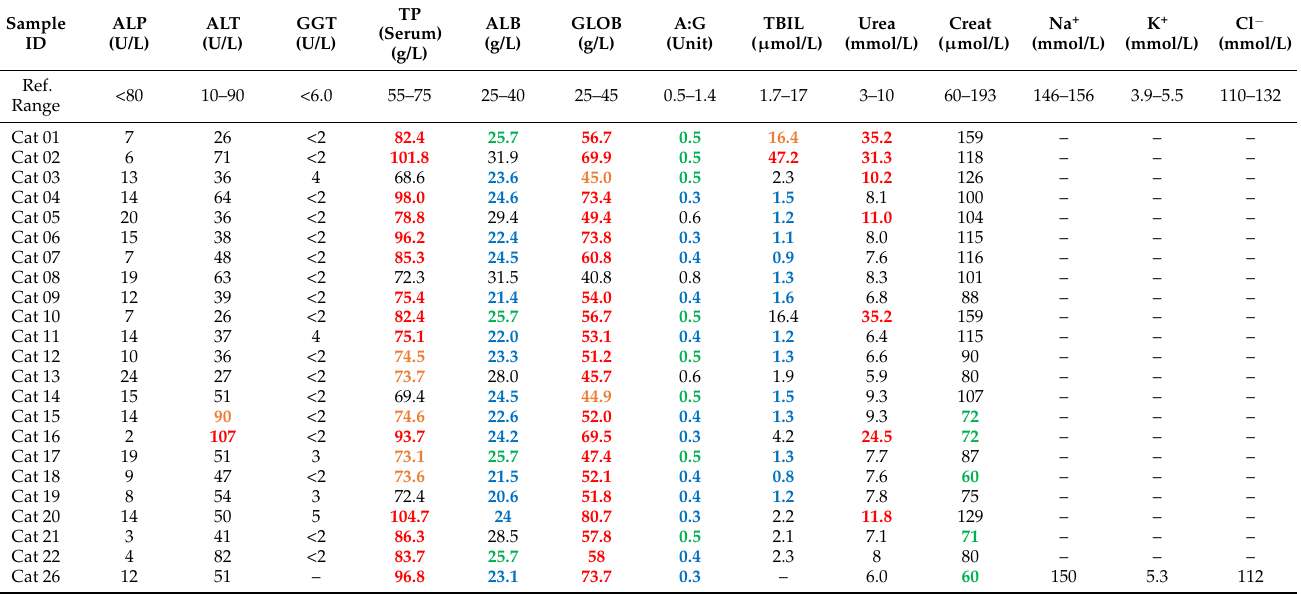
Table 5. Serum biochemistry findings for a total of 23 (22 shelter and 01 privately owned) cats manifested acute/chronic infectious respiratory disease